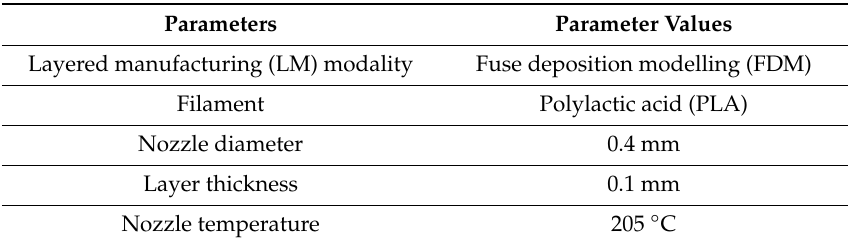
Table 2. Settings of the 3D printer.